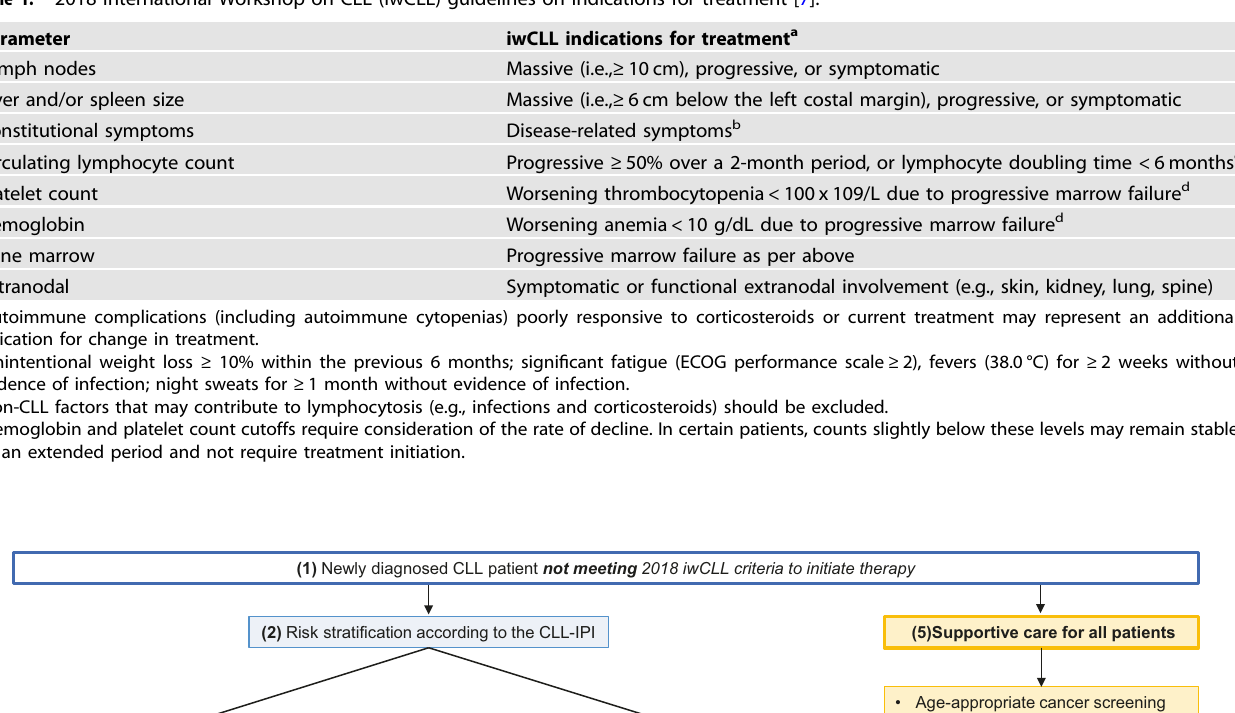
Table 1. 2018 International Workshop on CLL (iwCLL) guidelines on indications for treatment [7].